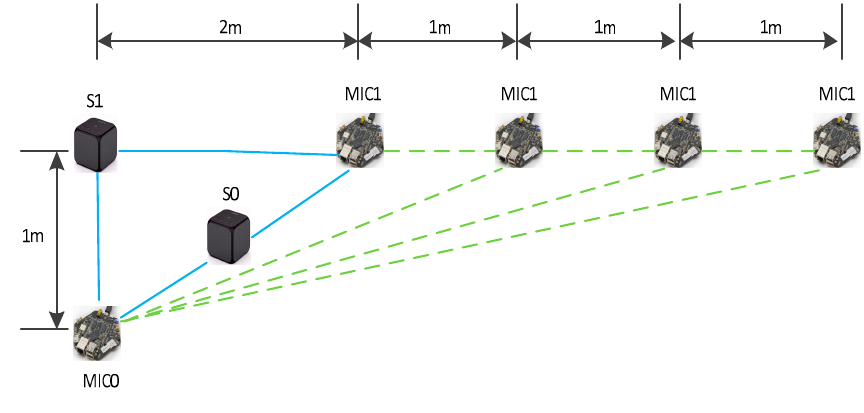
Figure 16. Schematic diagram of the evaluation method.